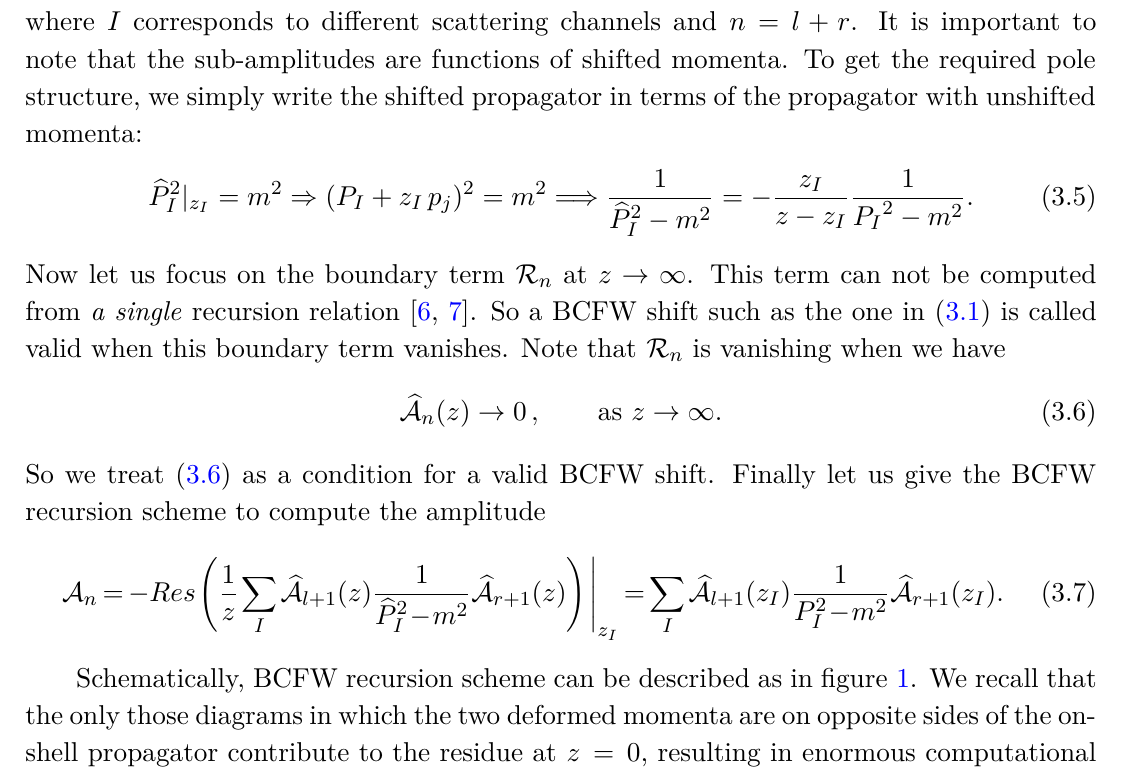
JHEP03(2021)295